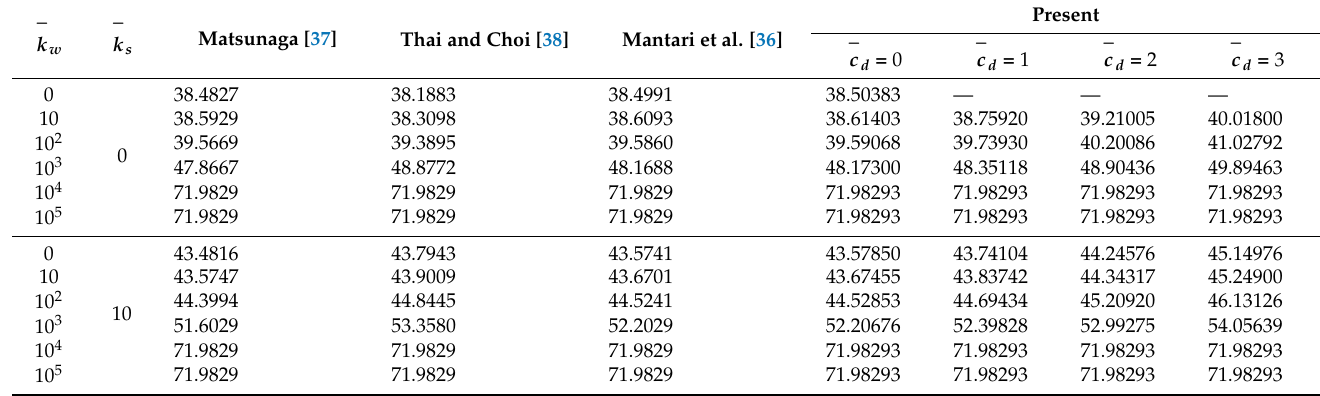
Table 3. Non-dimensional natural frequencies ω = ω a 2 on Visco-Winkler-Pasternak foundations ( a / h = 5, i = 1, j =